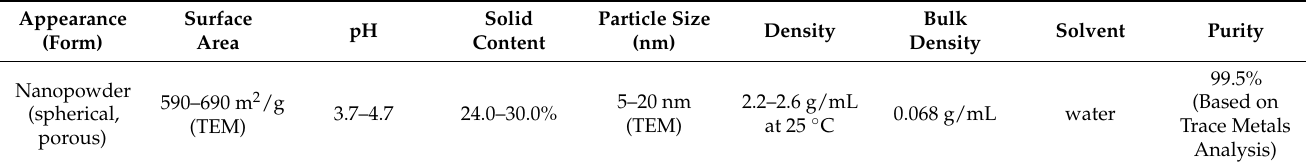
Table 1. Specifications of the SiNPs used in the current